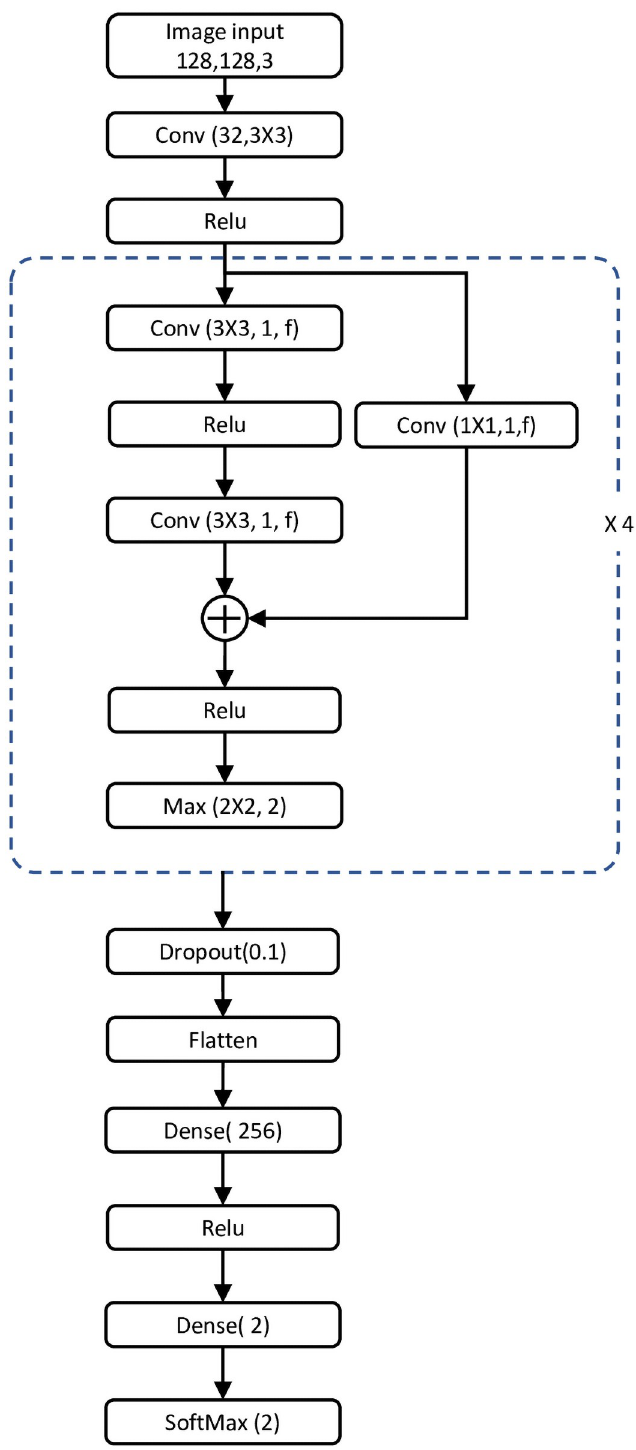
Fig 1. Proposed 2D-CNN network for OSA event detection. “Conv(k,s,f)” denotes a convolutional layer where k , s , and f are the kernel size, stride size, and number of filters, respectively. “Max(p,s)” denotes a max-pooling layer where p and s are the pool size and stride size, respectively. The values for the filter sizes “f” in the four residual blocks are 32, 64, 96, and 128.